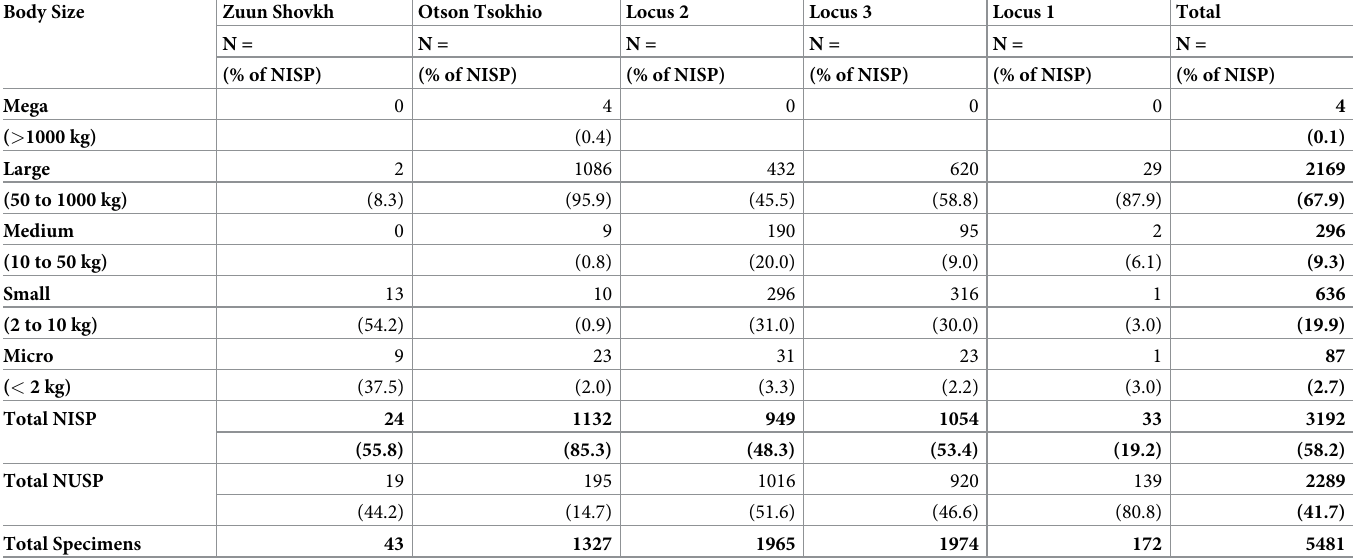
NISP = Number of Identified Specimens, NUSP = Number of Unidentified